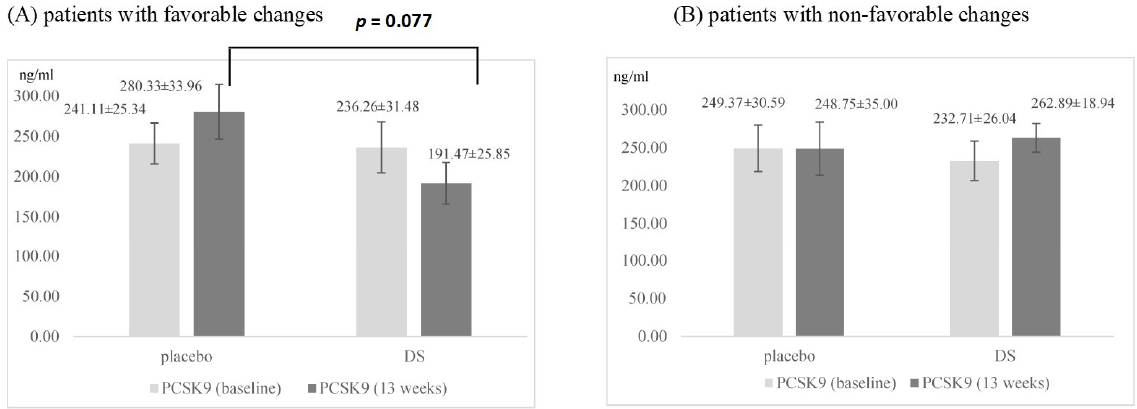
Figure 3. Serum PCSK9 levels at baseline and after 13 weeks of supplementation in patients ( A ) with favorable changes of LDL-C and HDL-C and ( B ) with non-favorable changes of LDL-C and HDL-C. Columns represent mean group values ± SEM. Abbreviations: HDL-C, high density lipoprotein cholesterol; LDL-C, low density lipoprotein cholesterol; PCSK9, proprotein convertase subtilisin kexin type 9.